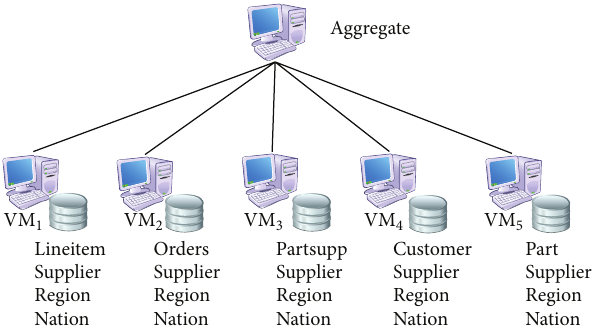
Figure 9: Architecture of the proposed system.